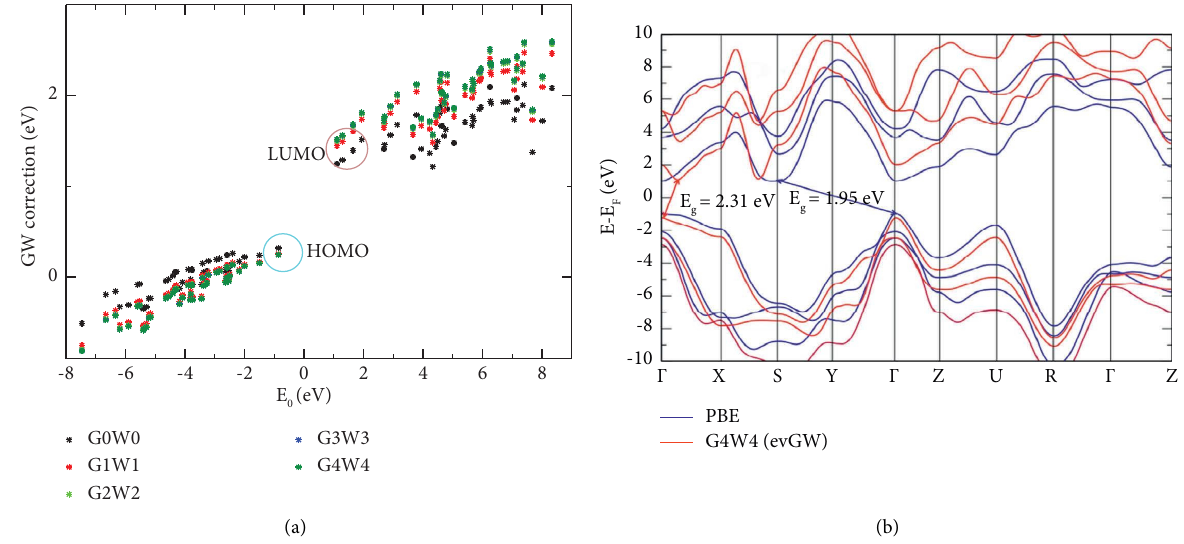
Figure 2: Quasi-particle bandgap calculation: (a) the convergence test of self-consistent GW on eigenvalues only for four iterations and (b) QP band structure calculation using evGW and DFT (PBE) methods.